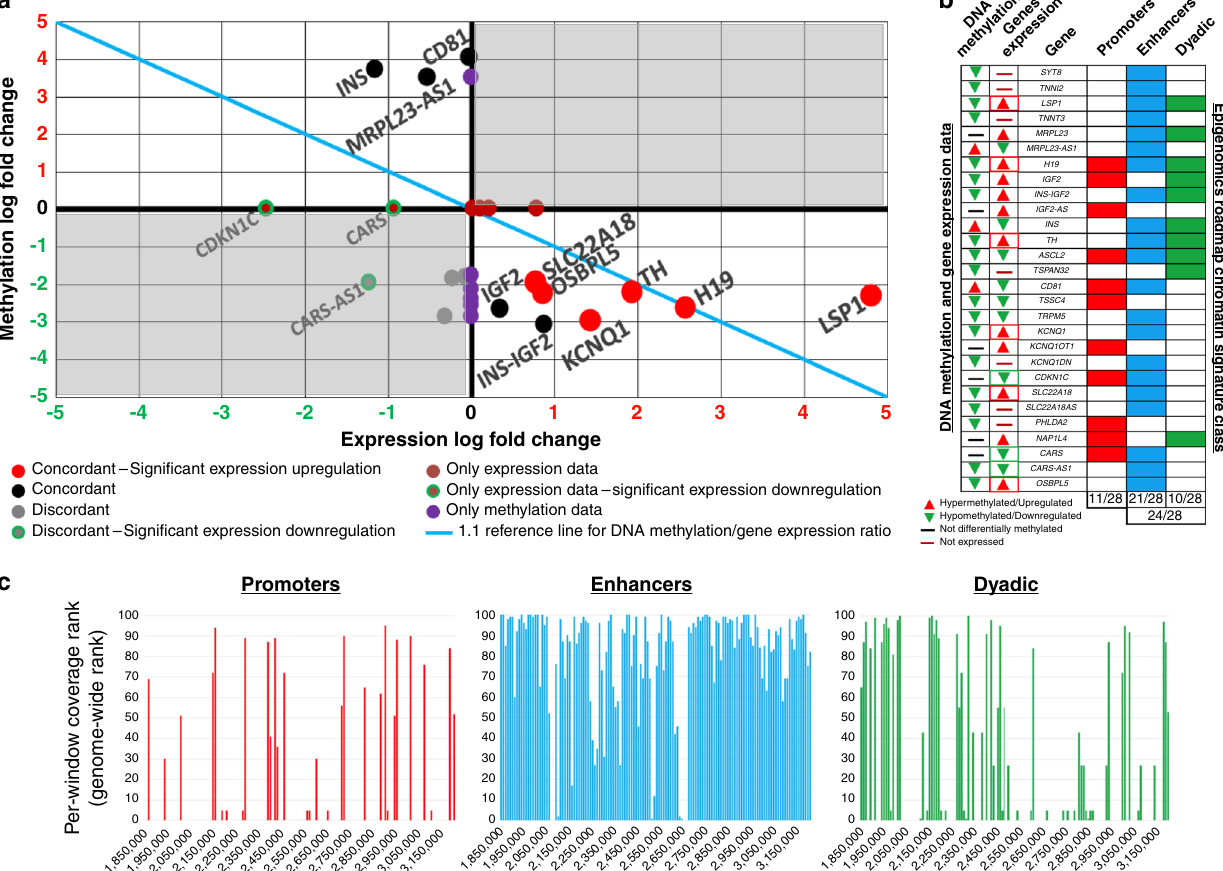
Fig. 2 Promoter DNA methylation versus gene expression. a Poor correlation between promoter methylation and gene expression. The X axis shows the gene expression log-fold change as reported previously 10 . The Y axis reports the DNA methylation log-fold change between insulinomas and beta cells, calculated as per Du et al. 17 . The top right and bottom left corners of the graph are shaded in gray, to represent “ discordant ” regions of promoter DNA methylation and gene expression. Since it is expected that promoter hypermethylation would favor gene silencing, and promoter hypomethylation would favor gene expression, these quadrants highlight genes that do not follow this axiom (see Supplementary Data 9 for details). b Chromatin signature of the promoters in the target region. The rows display the 28 genes in the target region for which either DNA methylation or gene expression 10 data are available. The two columns to the left of the gene names display the promoter DNA methylation status and the expression status of the genes indicated. Red arrowheads indicate statistically signi fi cant upregulation and green arrowheads downregulation. For DNA methylation, all data are from statistically signi fi cant differentially methylated CpGs. For gene expression, arrowhead red and green boxing represent statistical signi fi cance. The last three columns score, as per the Roadmap Epigenomics Project 18 , the presence of promoter, enhancer, or dyadic chromatin signatures in the promoter region of each gene. c Relative abundance of promoters/enhancers/dyads chromatin signatures in the 11p15.5-p15.4 target sub-region. The Y axis reports the genome-wide rank of the coverage of each window by sequences with promoters/enhancers/dyads chromatin signatures. A strong enrichment signal can be detected for enhancers (mean rank = 82, scored windows = 131) as compared to both promoters (mean rank = 52, scored windows = 30) and dyads (mean rank = 53, scored windows = 63). See Supplementary Data 11 for details. Note that the 11p15.5-p15.4 target sub-region is heavily enriched for enhancer